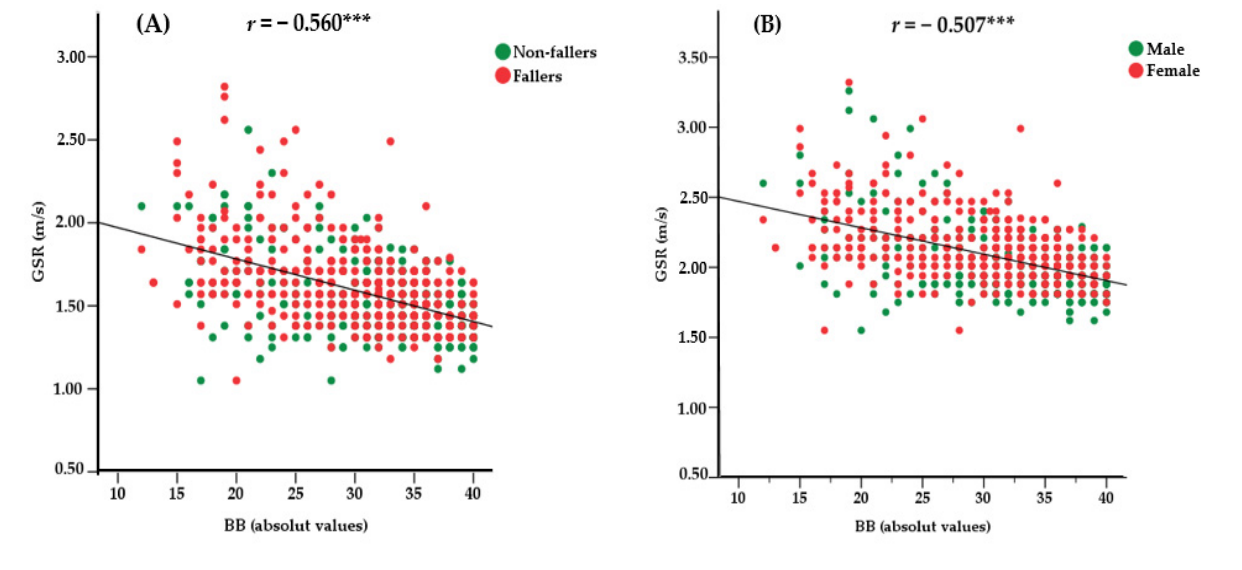
Figure 3. Scatterplot of correlation between GSR and BB performance. m/s = meters per second. ( A ) Results according to the history of falls in the last 12 months; ( B ) Results by sex; *** p < 0.001.